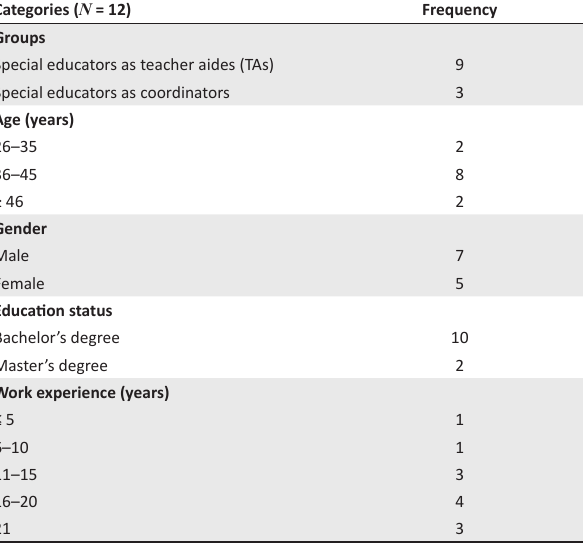
TABLE 1: Demographic characteristics of